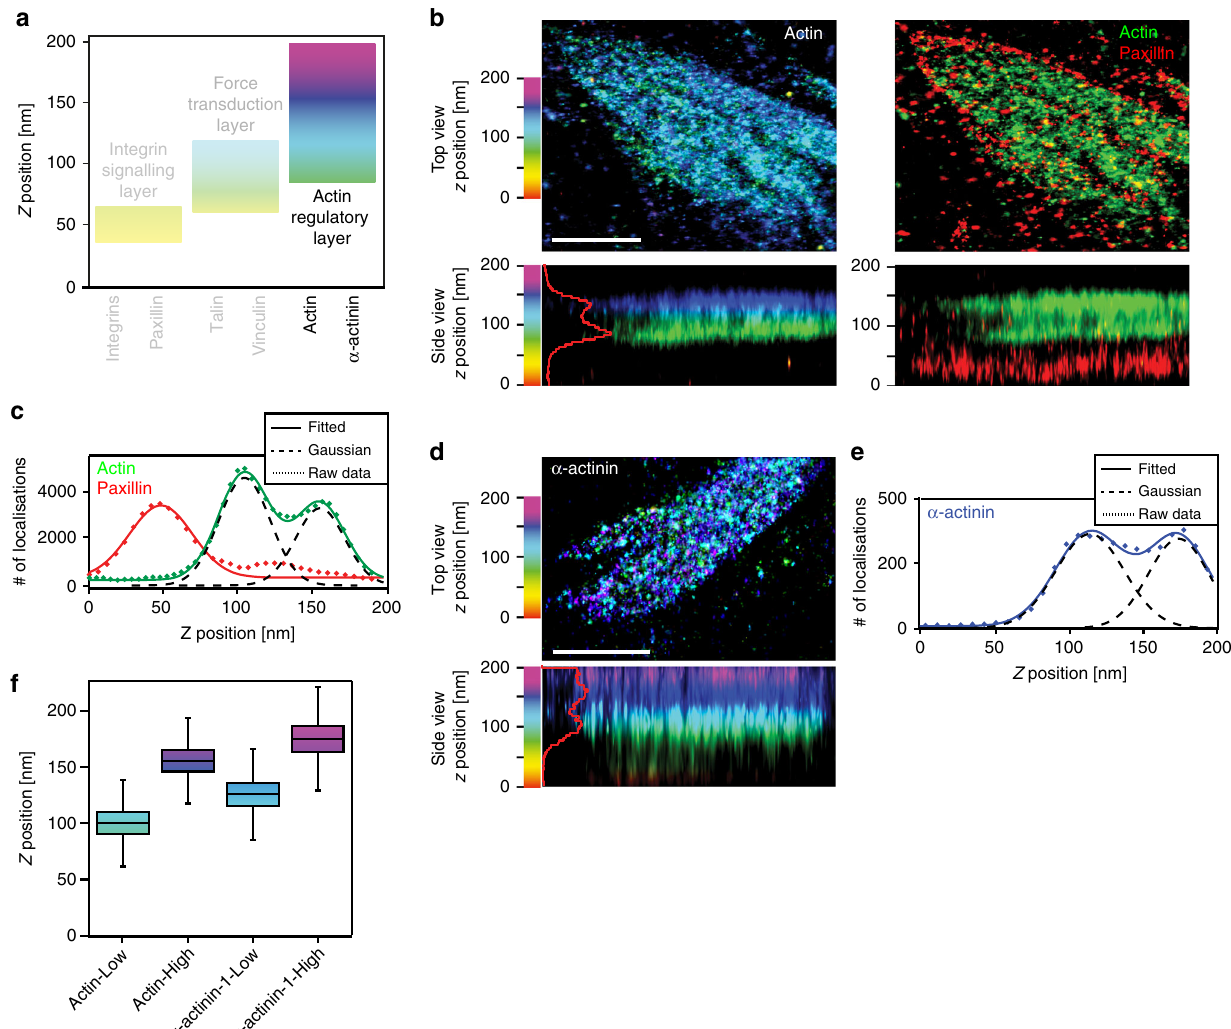
Fig. 5 Actin and α -actinin-1 lateral distribution. a Schematic representation of the different FA layers previously identi fi ed using iPALM in U2OS cells, colour bars highlight the z range for each of the three layers and the actin-regulatory layer containing actin and α -actinin-1 is emphasised over other layers. b Two- colour iPALM images of Eos-tagged actin and endogenous paxillin in a cornerstone FA. One individual cornerstone FA is displayed. Where localisation of actin is displayed separately, top-view and side-view images are colour-coded as a function of the z -position of the actin molecules. Where fl uorescence channels are merged (paxillin, red; actin, green), the z position is only displayed in the side view and the colours represent the fl uorescence signal for each protein. Scale bar 1 μ m. c Z density pro fi le of paxillin (red) and actin (green) displaying the number of localisations as a function of the z position in an individual cornerstone adhesion. Dotted lines correspond to the experimental data, while solid lines correspond to the fi tted data obtained using either a single Gaussian distribution (paxillin) or a sum of two Gaussian distributions (actin). Dashed black lines highlight these two Gaussian distributions. d iPALM image of Eos-tagged α -actinin-1 in an individual hPSC cornerstone FA. Top-view and side-view images are colour-coded as a function of the z - position of the α -actinin-1 molecules. Scale bar 1 μ m. e Z -density pro fi le of α -actinin-1 (purple) showing the number of localisations as a function of the z position. Dotted line corresponds to the experimental data while the solid line corresponds to the fi tted data obtained using a sum of two Gaussian distributions (dashed black lines). f iPALM analysis of the Z centre of actin (actin low n = 28 biologically independent ROIs, actin high n = 47 biologically independent ROIs) and α -actinin-1 ( α -actinin high n = 31 biologically independent ROIs, α -actinin low n = 27 biologically independent ROIs) in hPSC cornerstone adhesions. “ Low ” and “ High ” denote separate peaks in the distribution of the same protein. Source data are provided as a Source Data fi le. Boxes display the median, plus the 1st and 3rd quartiles (IQR: 25th – 75th percentile). Whiskers correspond to the median ± 1.5 ×